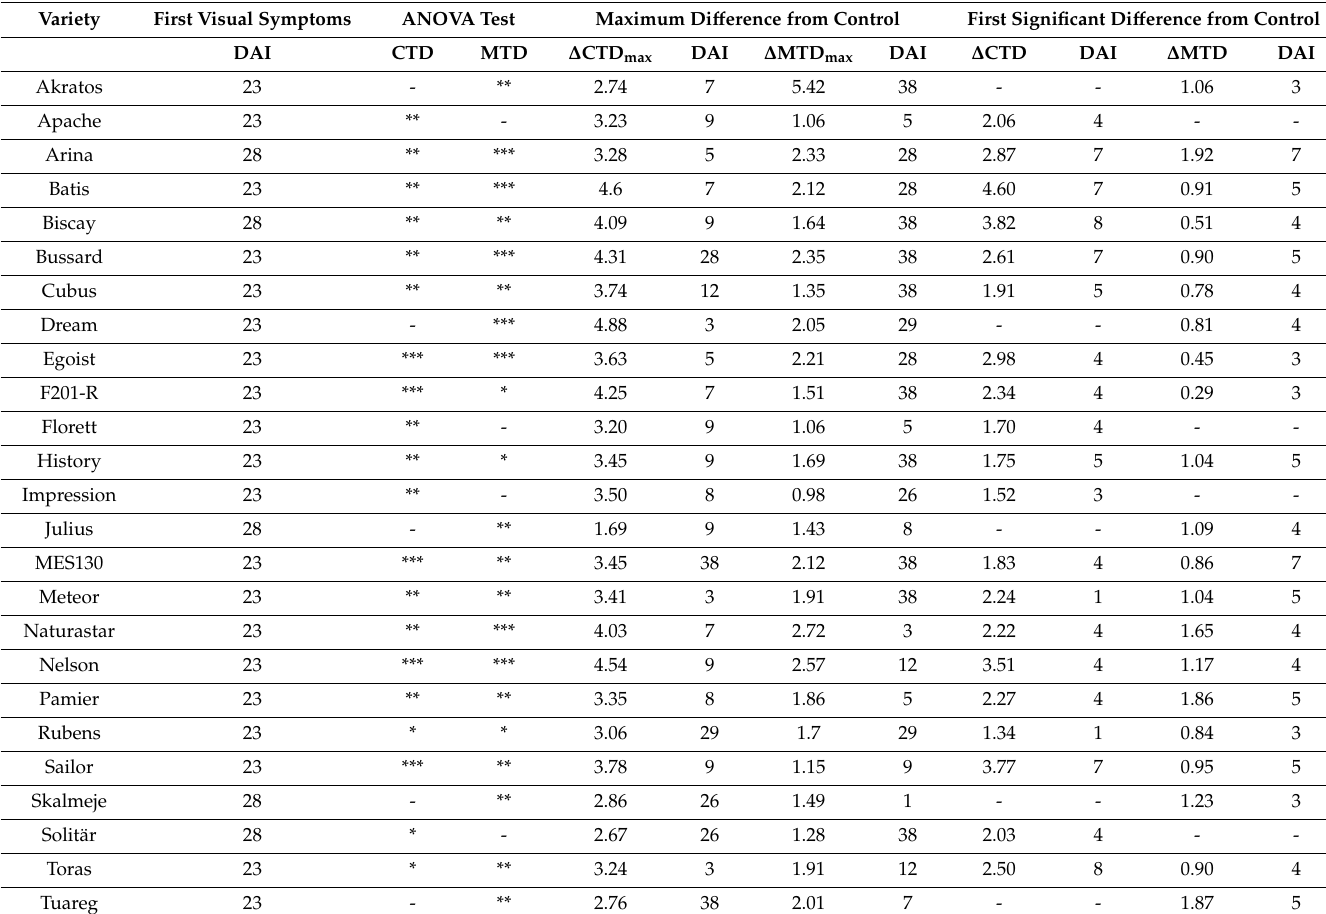
Table 2. ANOVA test between non-inoculated and Z. tritici treatment on the last day of the field experiment (38 DAI), di ff erence in canopy temperature di ff erence (CTD), maximum temperature di ff erence (MTD) and the maximum di ff erence from control treatment (DAI = days after